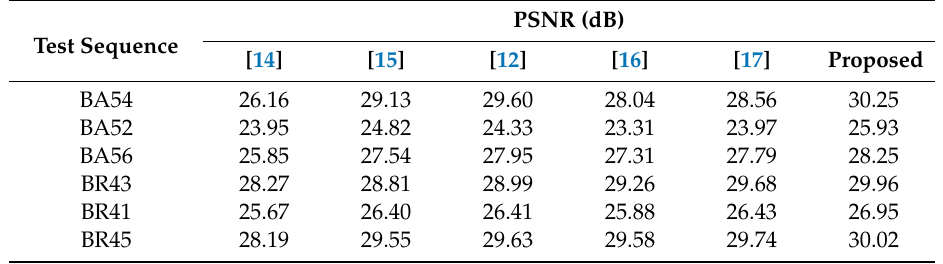
Table 1. Average peak signal-noise ratio (PSNR) comparison of the proposed and previous methods.